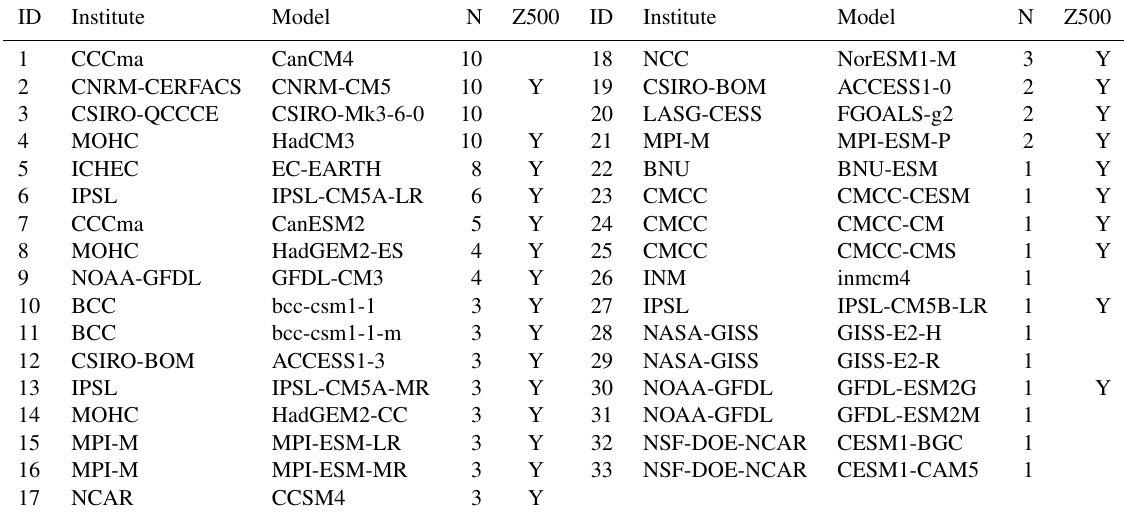
Table A1. CMIP5 models used in the analysis. The model IDs correspond to those in Figs. 2 and 6. Models are arranged in descending order of ensemble size ( N ). A “Y” in the Z500 column indicates that daily output for 500hPa geopotential heights was available for the specified